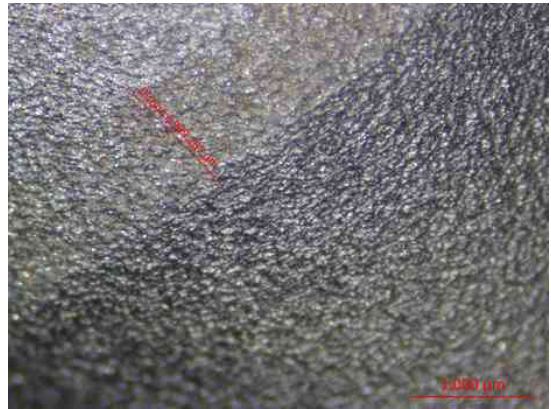
Figure 3. Cr CS coated pressure tube - detail of the bottom weld.